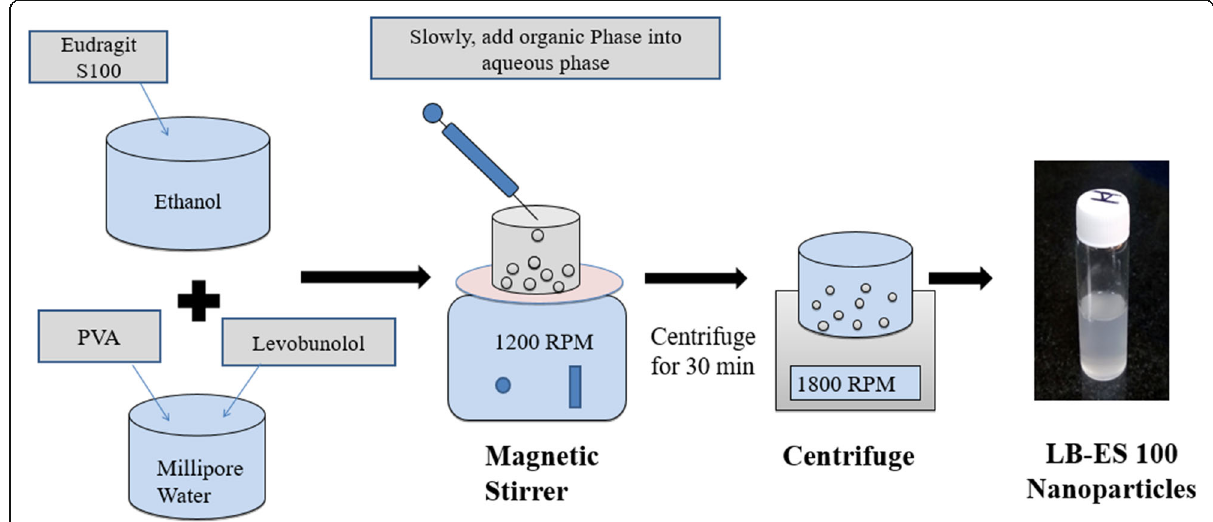
Fig. 2 Schematic representation of various steps involved in ES 100 nanoparticle preparation